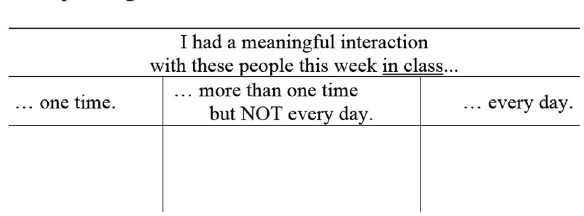
FIG. 2. An excerpt from the SNA survey that was given in the Modeling Instruction classroom